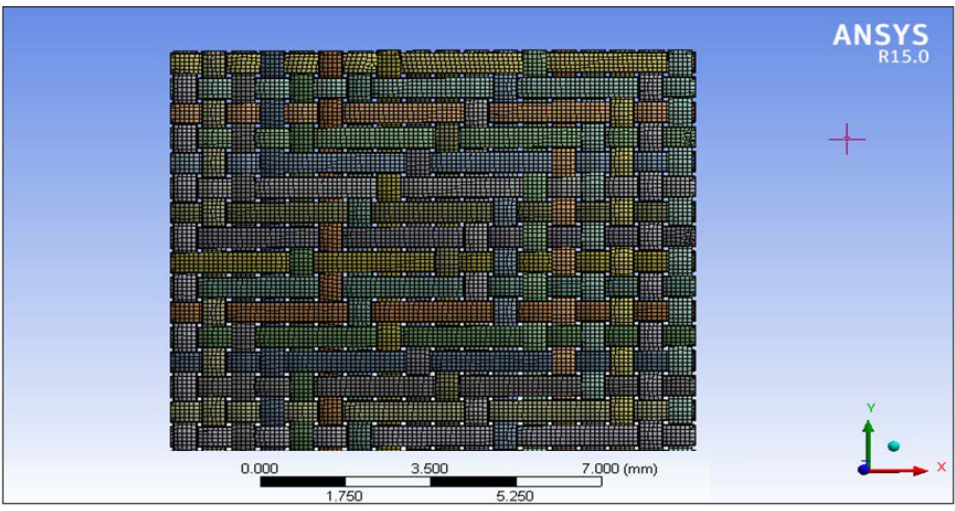
Figure 10. Mesh Figure 10. Mesh generation.